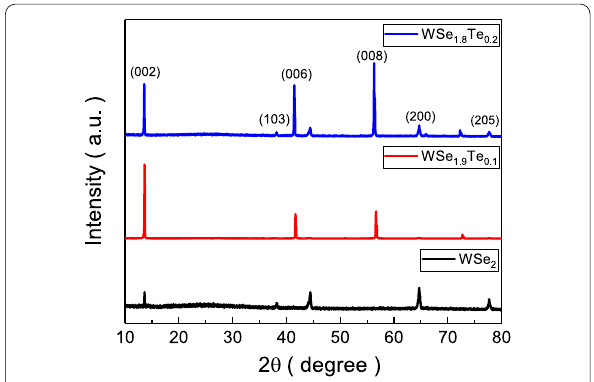
Fig. 1 The XRD spectra of the WSe 2 , WSe 1.9 Te 0.1 and WSe 1.8 Te 0.2 single crystals. The peak positions are consistent with the database of the WSe 2 crystal. The peak shift is observed in the WSe 1.9 Te 0.1 and WSe 1.8 Te 0.2 . The shift of the diffraction peaks to lower angles in the crystal with more Te atoms replacement reflects an enlargement of the lattice constants with increasing Te content. The X‑ray diffraction database is JCPDS No.